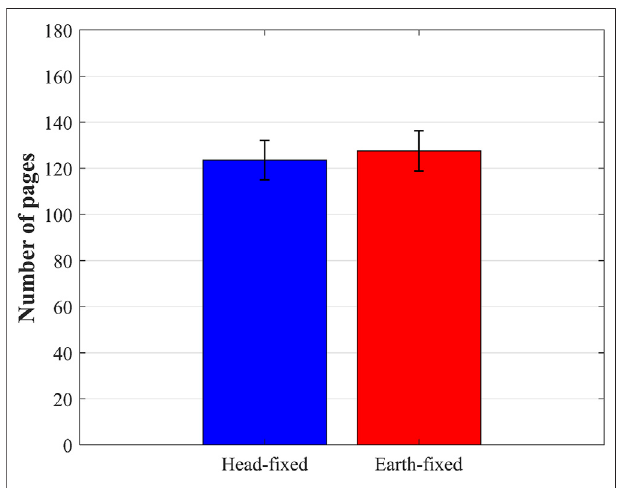
FIGURE 9 | Reading task